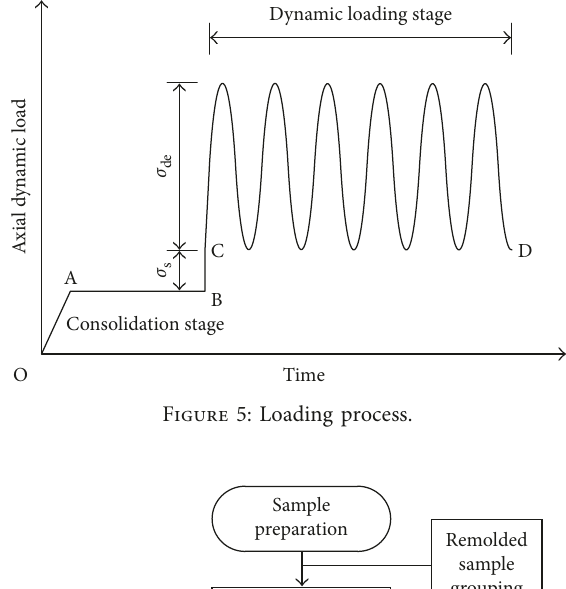
Figure 7: Cumulative strain, ε remolded specimens).